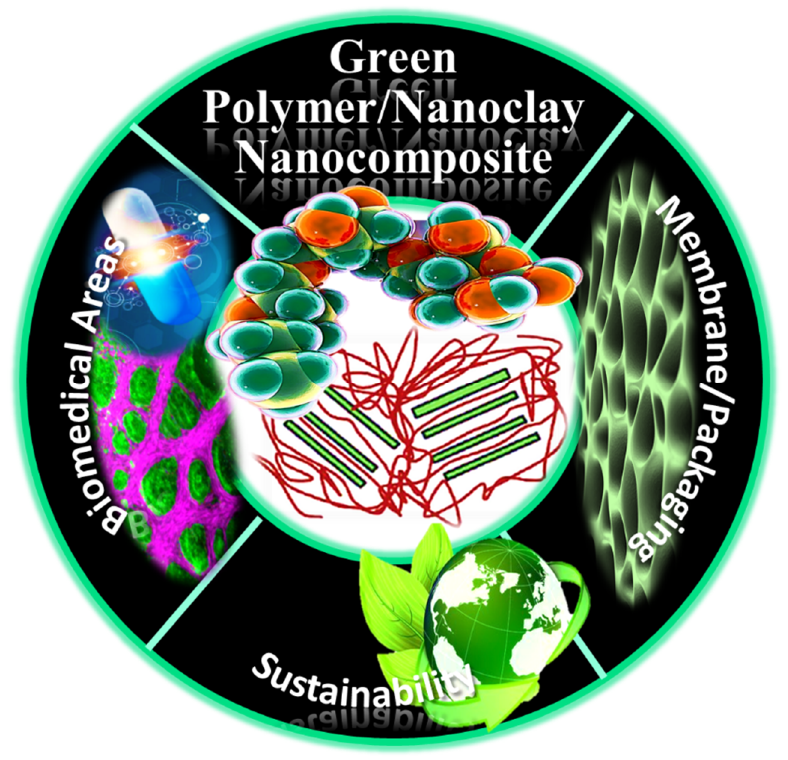
Figure 7. Applications of green polymer/nanoclay nanocomposite.